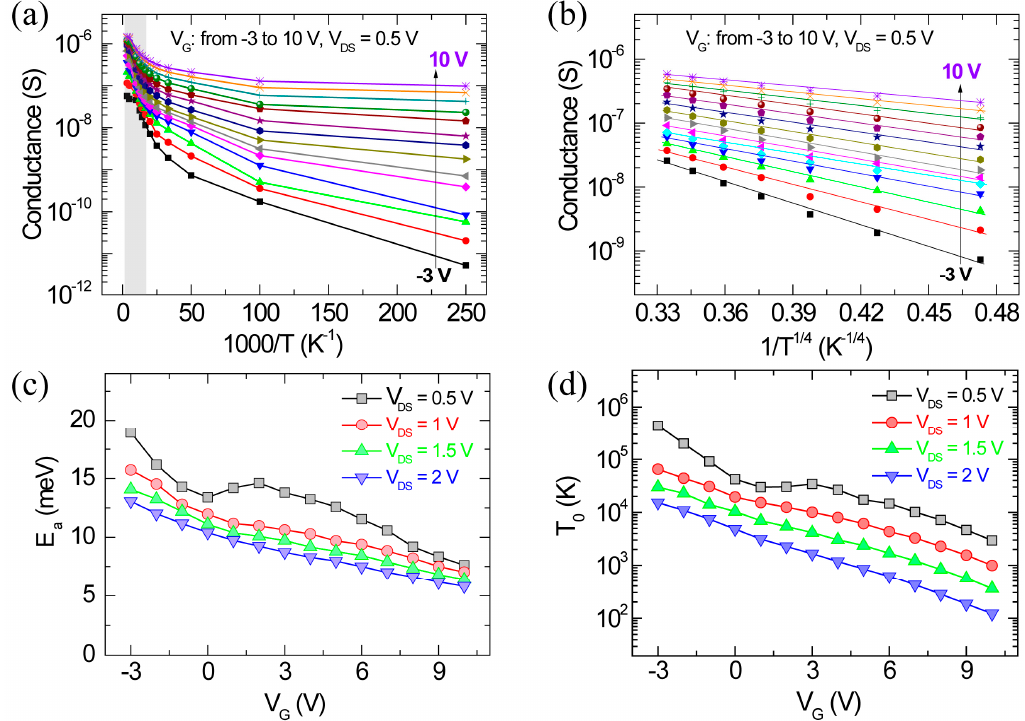
Figure 4. ( a ) Arrhenius plots of the conductance ( G ) versus 1000 / T at di ff erent gate voltages from − 3 to 10 V for V DS = 0.5 V. ( b ) Semilogarithm plots showing the temperature dependence of conductance ( G ) vs 1 / T 1 / 4 fitted by Equation (5) at di ff erent gate voltages for V DS = 0.5 V. The activation energy ( E a ) ( c ) and characteristic temperature ( T 0 ) ( d ) depending on the applied gate and drain voltages.